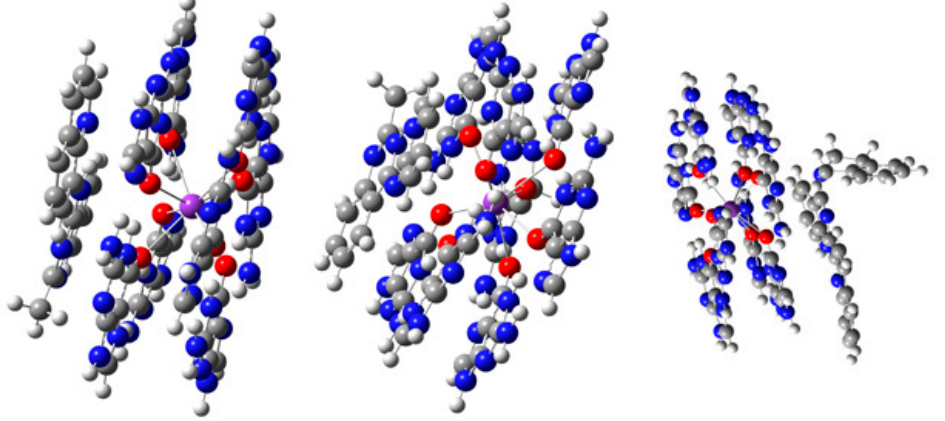
Figure 3. Complexes of model two-layered quadruplex Q2 with hetero-ligands, left: Q2 + 4 ; center: Q2 + 9 , N3H tautomer; right: Q2 + 1 . In addition, see Figure S1 for opposite conformation of 1 .